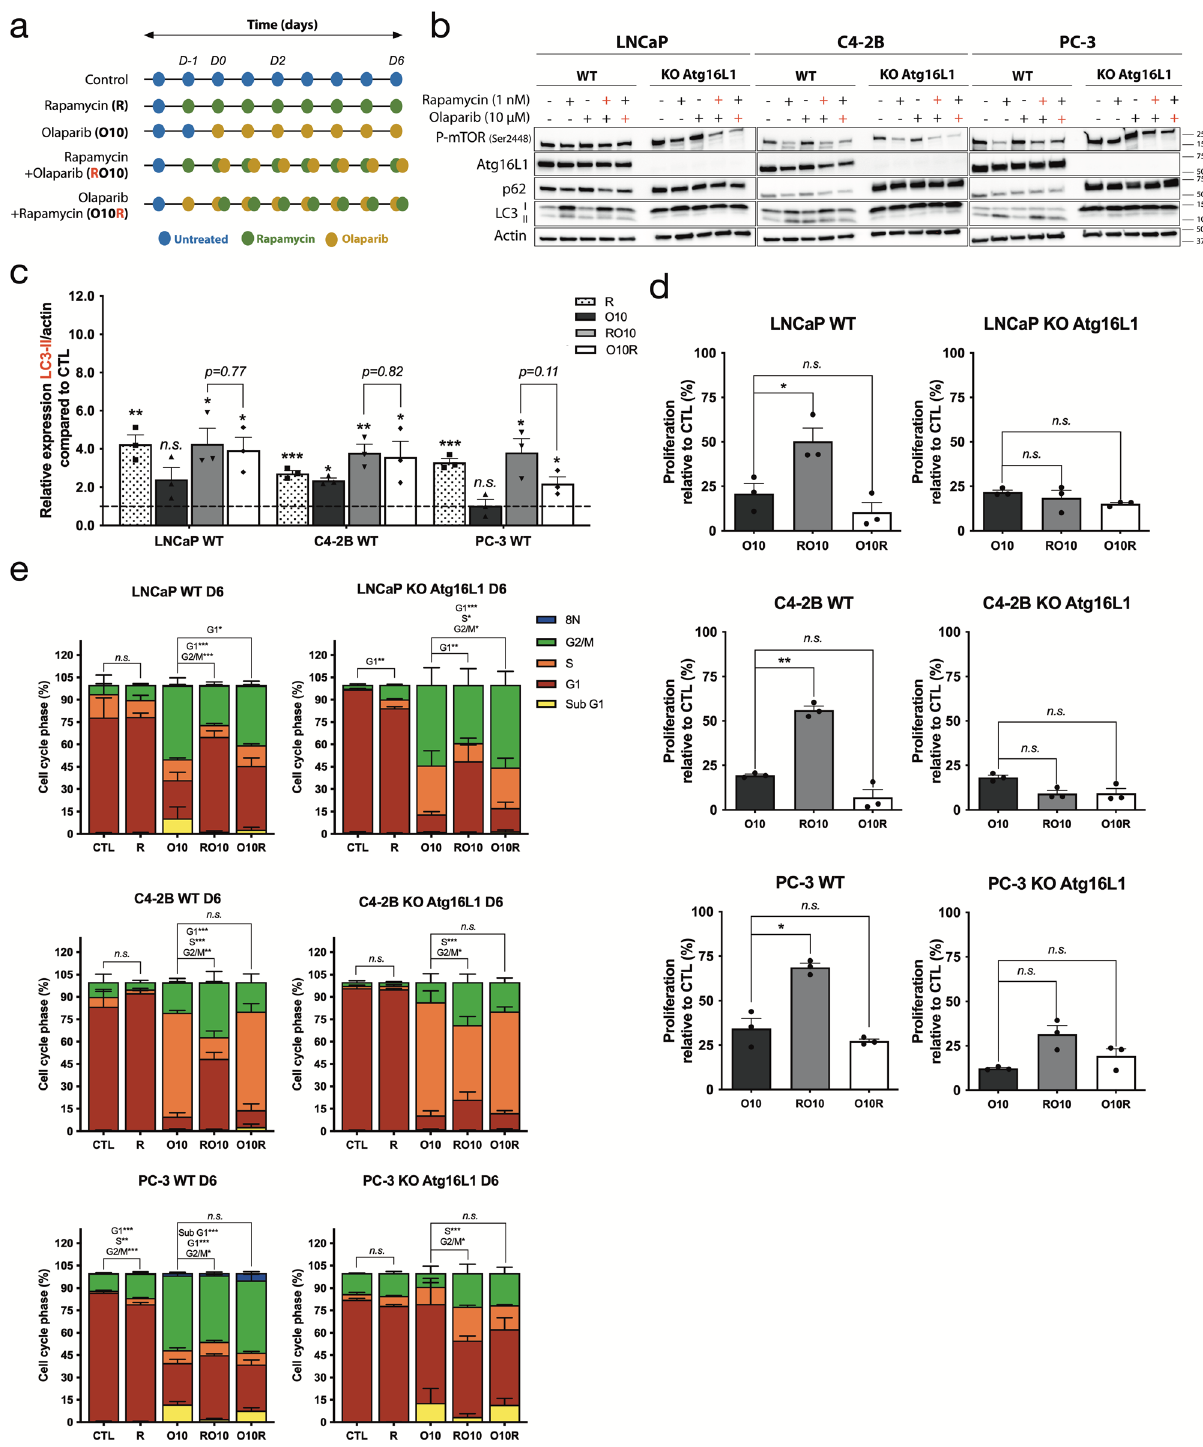
Fig. 2 Pre-activation of autophagy by rapamycin induces a protective effect against olaparib. a Treatment timeline of cell lines. Cells were treated with 10 µ M olaparib alone (denoted as O10) or received 1 nM rapamycin 24 h before (RO10) or 24 h after (O10R) the start of olaparib treatment. Experiments were conducted for 6 days. b Western blot analyses of autophagy induction after olaparib and rapamycin treatments in WT and KO Atg16L1 cell lines at day 2. Rapamycin (red + ) denotes RO10. Olaparib (red + ) denotes O10R. c Relative expression of LC3-II normalized with actin and compared to control (CTL) from b . d Cell proliferation of WT and KO cell lines under O10, RO10, or O10R treatments at day 6. e Quanti fi cation of cell cycle phase populations determined by fl ow cytometry following 6 days of treatment of WT and KO cell lines. For all data, the mean ± SEM of three independent experiments is shown. Data were analyzed using the two-tail Student t -test. n.s. = nonsigni fi cant. * p < 0.05, ** p < 0.01, and *** p < 0.001.